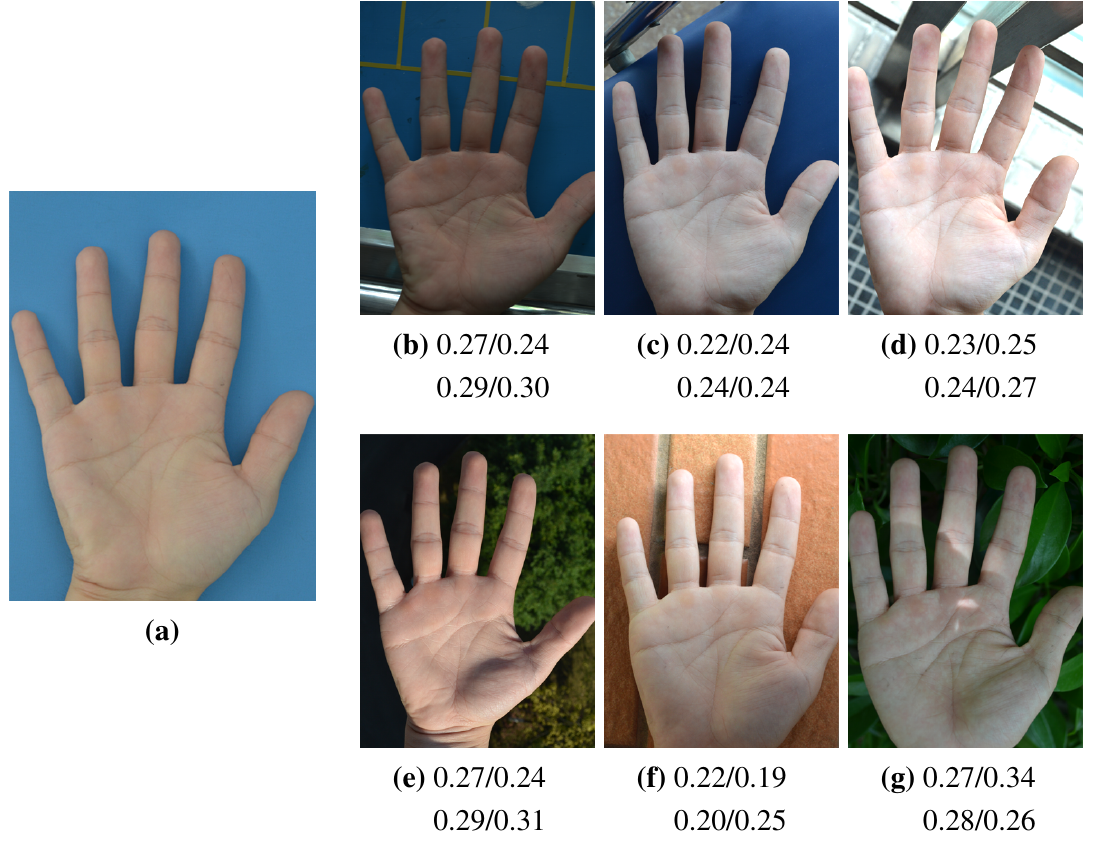
Figure 17. Some examples in typical scenes. ( a ) Ideal experimental environment; ( b – d ) indoor scenes under different illumination; ( e ) scene under direct sunlight; ( f ) scene under side light; ( g ) scene under non-uniform illumination and shadow. The four values under each image indicate the matching distances of the four IKP ROIs against (a), respectively. The threshold applied here is 0.41, the same as in Figure